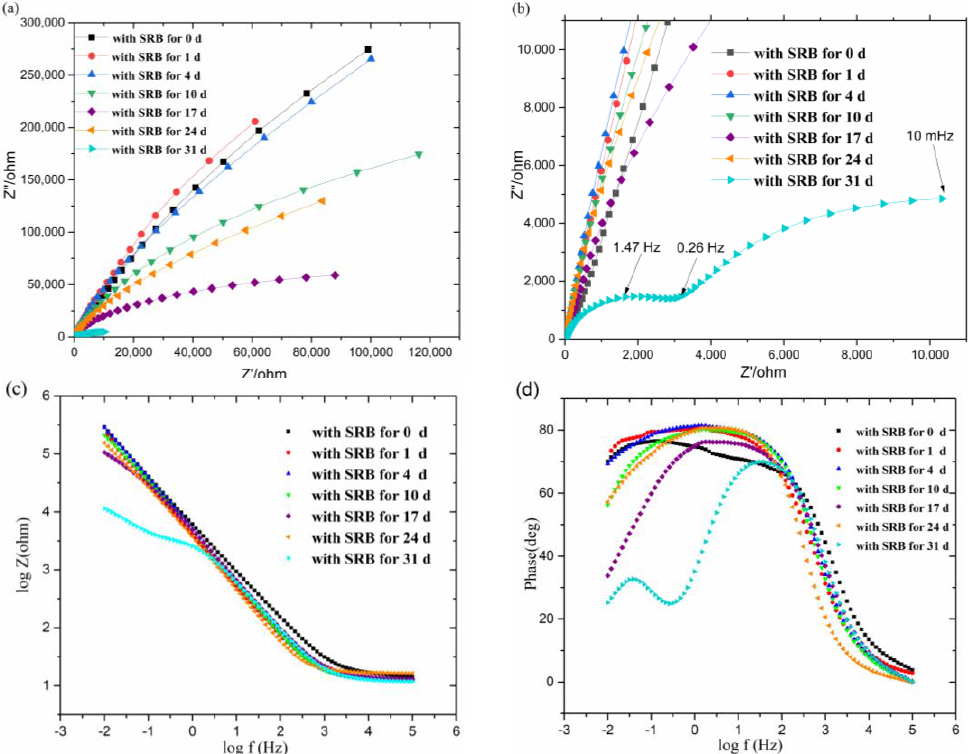
Figure 3. The electrochemical impedance spectroscopy (EIS) results for the titanium alloys in SRB solution (0–31 days). ( a ) Nyquist plots of impedance module for samples for di ff erent immersion time, ( b ) an enlarged view of the Nyquist diagram, ( c ) Bode plots (log | Z | – log ƒ ) of impedance module for samples for di ff erent immersion time, and ( d ) Bode plots (Ø – log ƒ ) of impedance module for samples for di ff erent immersion time.